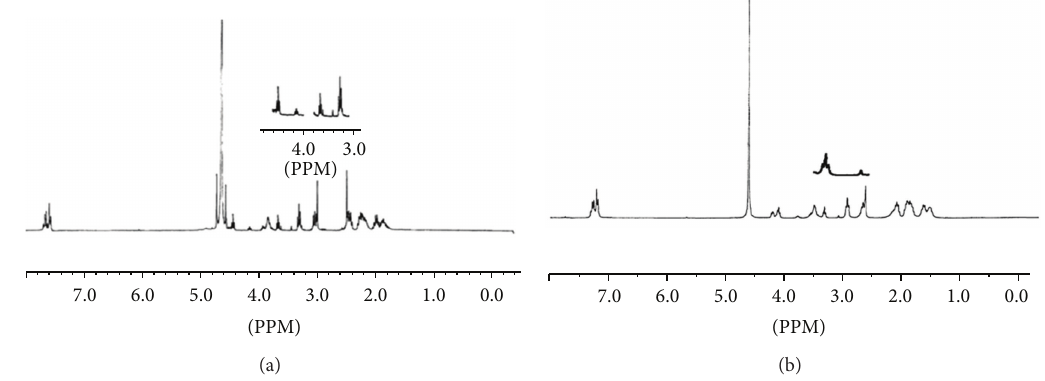
Figure 5: 1 H NMR spectrum of lisinopril in D 2 O/CD 3 CN (9/1, v/v). (a) 𝑇 = 298 K, (b) 𝑇 = 333 K.